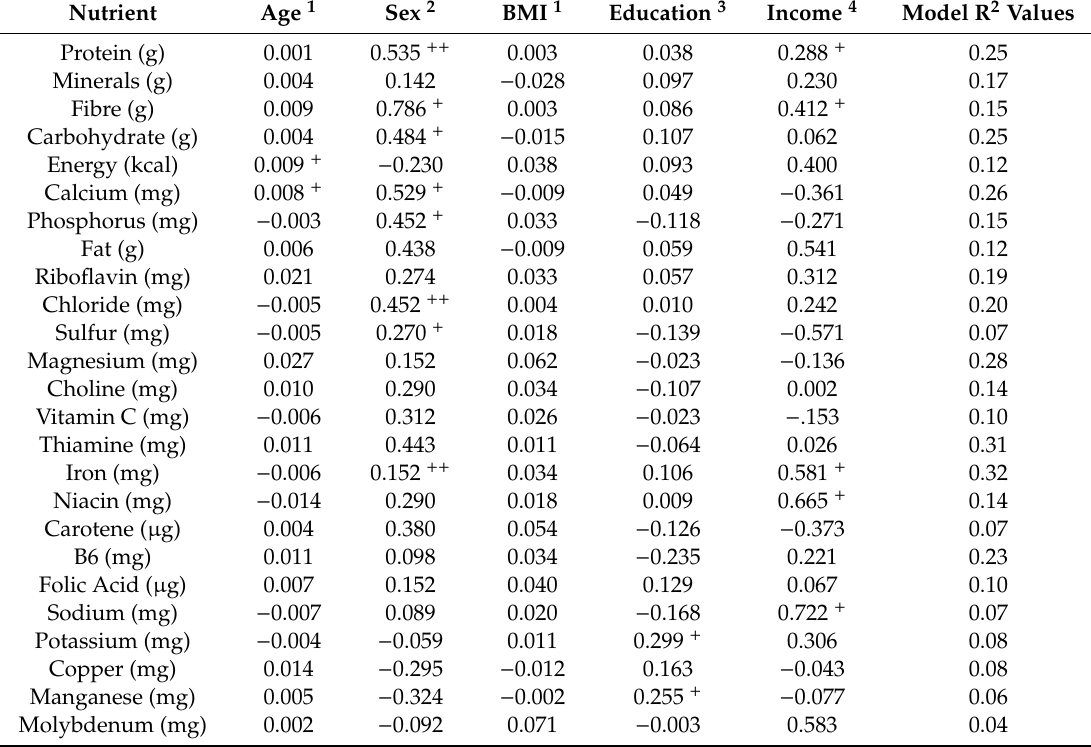
Table 3. Association between factors and di ff erences in intake estimates (regression coe ffi cients) using multiple regressions with nutrients as the dependent